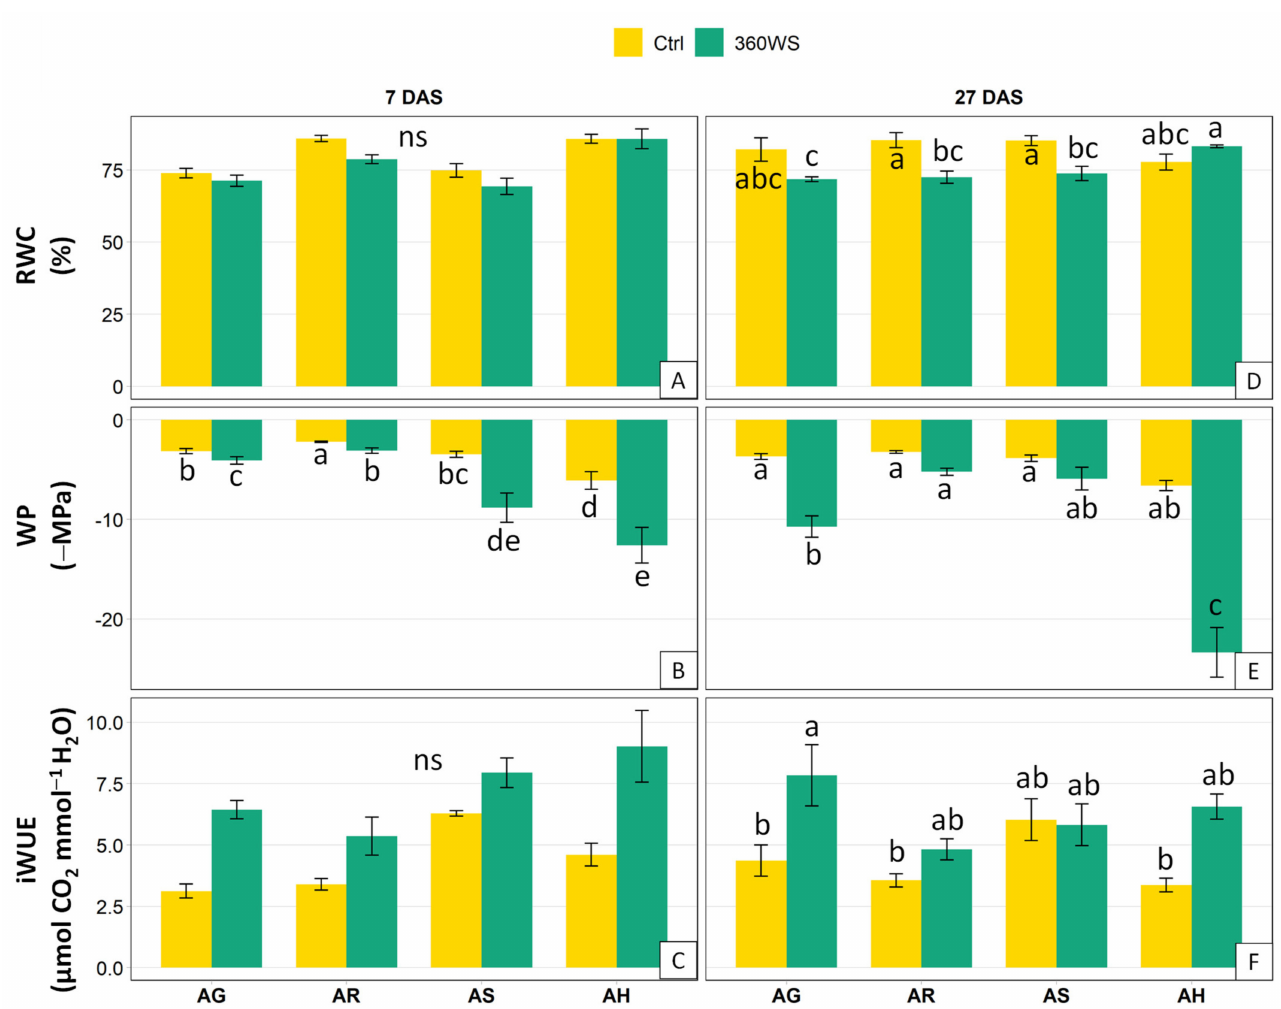
Figure 4. Leaf relative water content, leaf water potential, and intrinsic water use efficiency at 7 days after salt stress initiation ( A , B , C , respectively) and at 27 days after salt stress initiation (D, E , F , respectively) under control (Ctrl) and 360 mM water salinity (360 WS) in the four genotypes A. hortensis cv. green (AG), A. hortensis cv. red (AR), A. hortensis cv. scarlet (AS), and A. halimus (AH). Vertical bars indicate standard error ( n = 4). Different letters indicate significant differences at p <